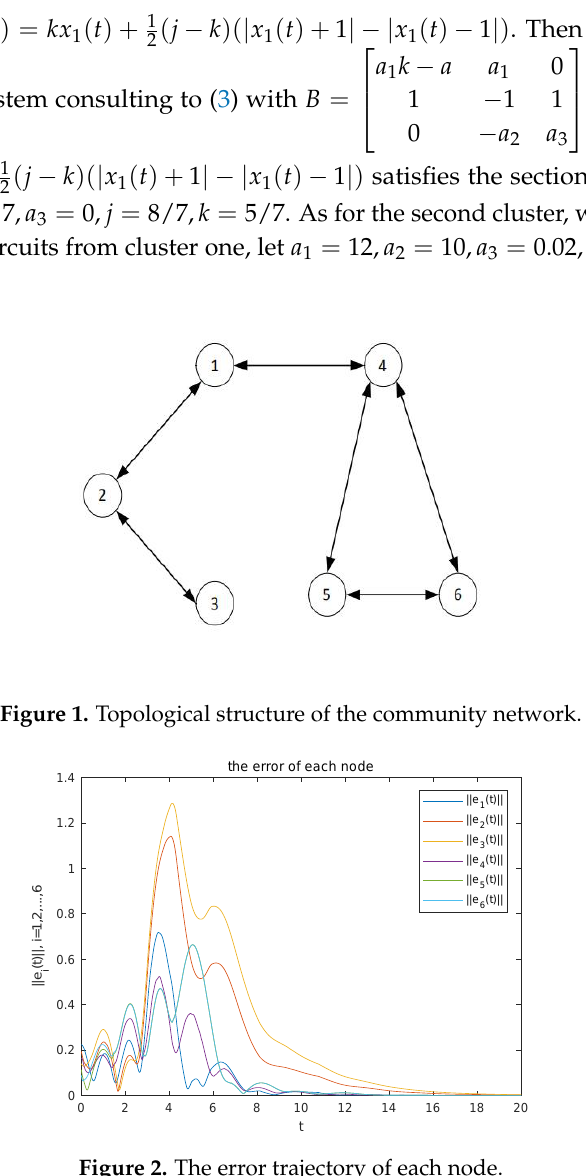
Figure 2. The error trajectory of each